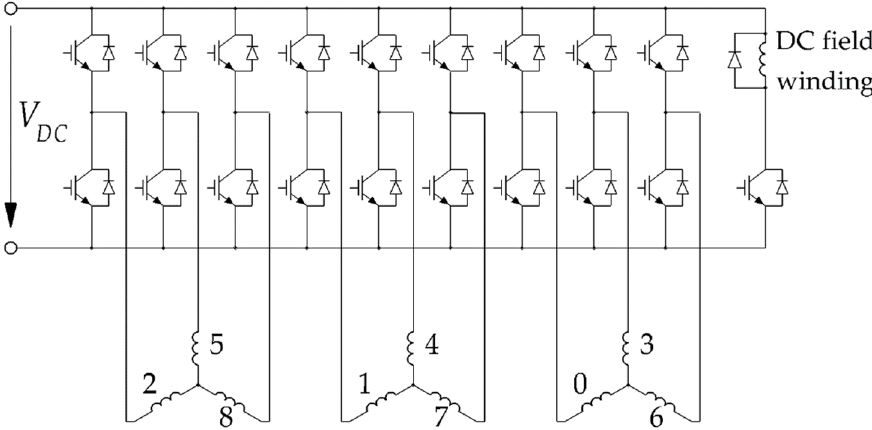
Figure 3. Scheme of the nine ‐ phase inverter with an additional DC chopper. The numbers show the order of the motor phases.